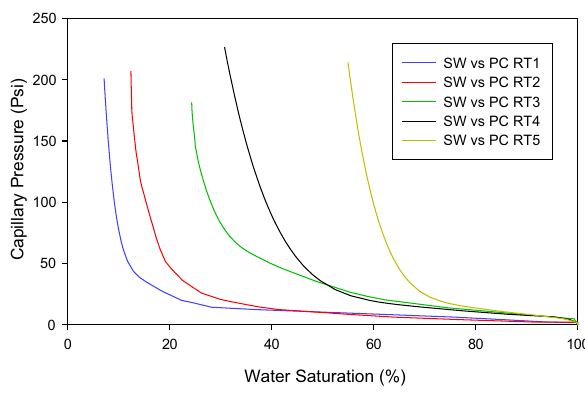
Fig. 6 Average capillary pressure curves of water–oil drainage pro- cess for different classes of